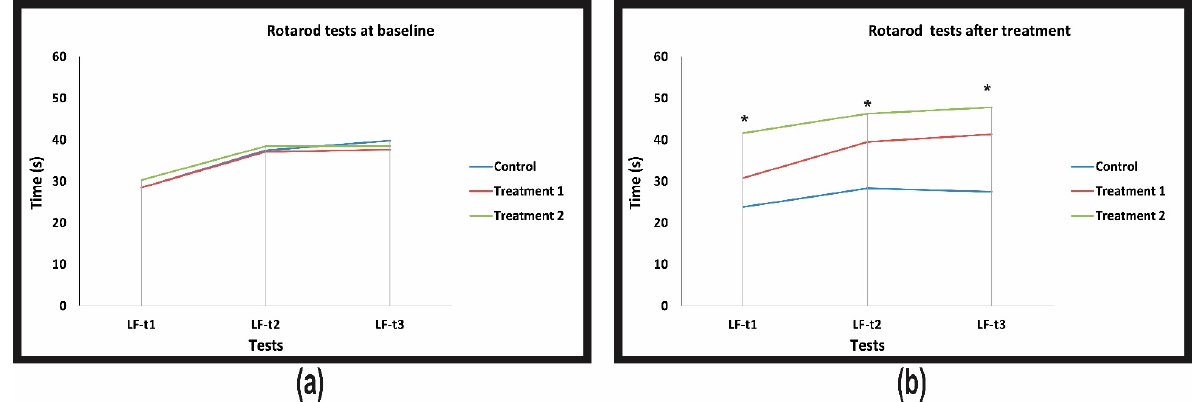
Figure 2. Timely evolution of rotarod neurological tests conducted on control and treated rats. ( a ) Rotarod tests at baseline; ( b ) rotarod tests after treatments. * Statistically significant result p < 0.05. Table 7. Regression analysis of each treatment group compared with the control group. Table 8. Averaged treatment effects for rotarod